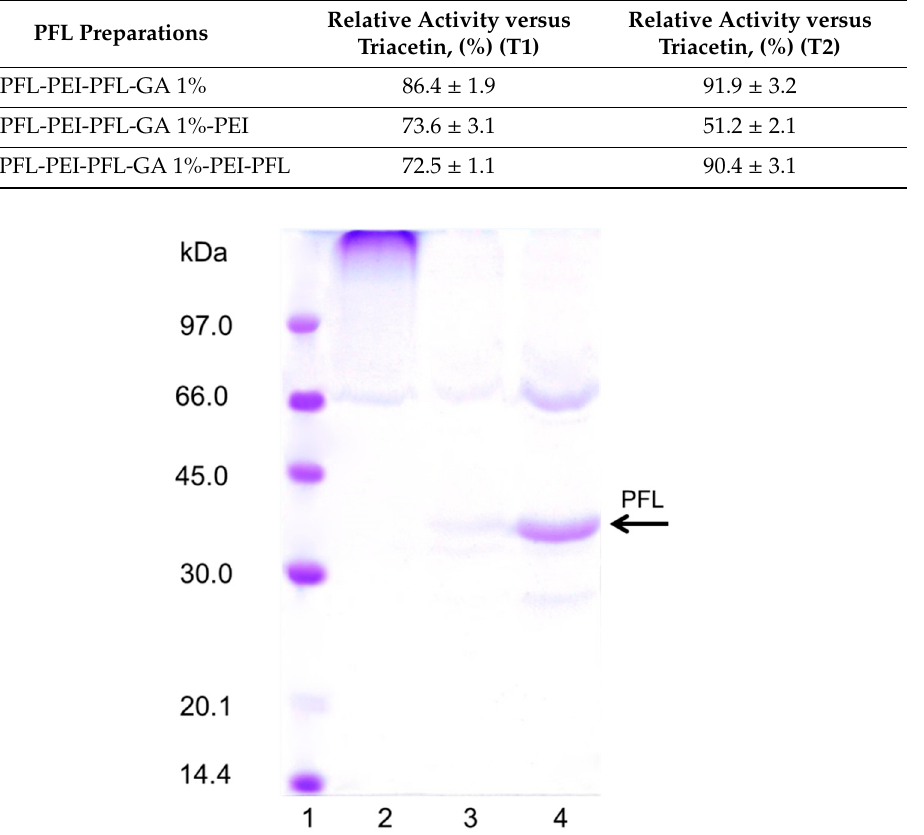
Figure 6. SDS-PAGE of the glutaraldehyde modified PFL preparations. The experiments were performed as described in Methods (load was 80 mg / g per layer). Lane 1: Low molecular marker; Lane 2: OA-PFL-PEI-PFL-Glutaraldehyde, Lane 3: OA-PFL-PEI-PFL-Glutaraldehyde-PEI, Lane 4: OA-PFL-PEI-PFL-Glutaraldehyde-PEI-PFL.